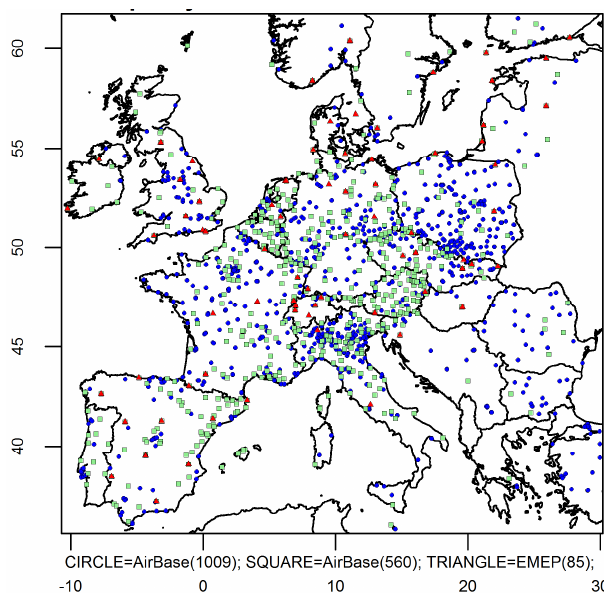
Figure 1. AirBase rural background (RB; green squares), AirBase Figure 1: AirBase RB (green squares), AirBase UB (blue dots) and EMEP stations (red triangles) 749 urban background (UB; blue dots) and EMEP stations (red trian- used for the model performance evaluation. 750 gles) used for the model performance